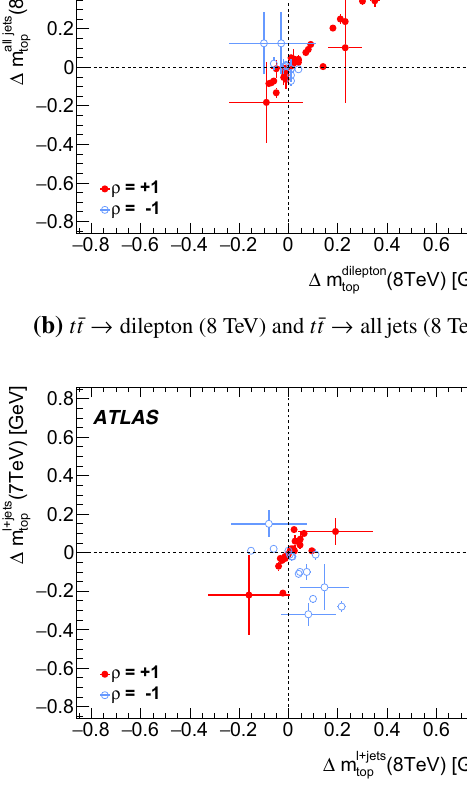
is observed for the t ¯ t → dilepton and t ¯ t → all jets measure- √ s = 8 TeV, shown in Fig. 7b. The prominent ments at 8 In the course of including more results into the combination of Ref. [14], the definitions of the variations were homogenized while leaving the estimator correlations unchanged. As a consequence, for the corresponding figures some of the points now are located in the respec- √ s = 8 tive other quadrant, e.g. for the t ¯ t → dilepton result at